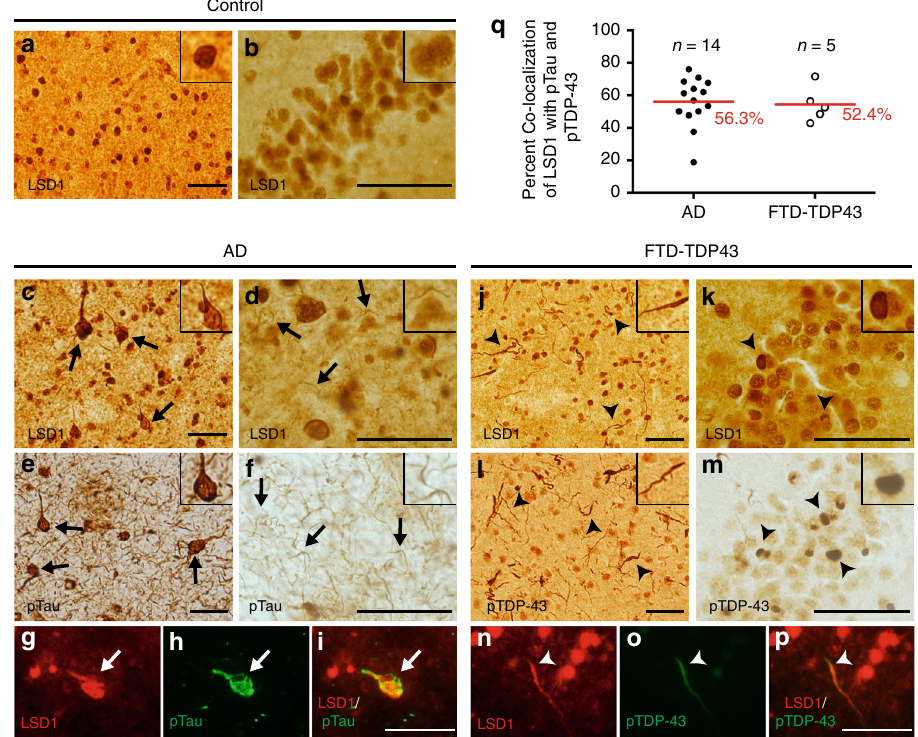
Fig. 6 LSD1 co-localization with pTau and pTDP-43 aggregates in AD and FTD. a , b LSD1 immunohistochemistry (IHC) showing expression of LSD1 in age-matched control frontal cortex a and hippocampus b . c , d Representative IHC images showing LSD1 immunoreactivity localized to cytoplasmic tangle- like aggregates ( c , arrows) and neurites ( d , arrows) in AD frontal cortex. e , f IHC images showing pTau (AT8 epitope) neuro fi brillary tangles ( e , arrows) and neuropil threads ( f , arrows) from the same AD frontal cortex as c , d . g – i Representative image of LSD1 ( g , red), pTau ( h , green), and merged i immuno fl uorescence (IF) showing co-localization of LSD1 with a pTau neuro fi brillary tangle in AD (arrow). j , k Representative IHC image showing LSD1 immunoreactivity localized to abnormal deposits in neurites ( j , arrowheads) and cytoplasmic inclusions ( k , arrowheads) in FTD-TDP43 frontal cortex j and hippocampus k . l , m IHC images showing pTDP-43 in neurites and cytoplasmic inclusions ( l , m , arrowheads) from the same FTD-TDP43 frontal cortex l and hippocampus m as j and k , respectively. n – p Representative image of LSD1 ( n , red), pTDP-43 ( o , green) and merged p IF showing co-localization of LSD1 with pTDP-43 in a neurite in FTD-TDP43 (arrowhead). Insets are magni fi ed views of LSD1 nuclear localization a , b and representative pathologies c – f , j – m . Scale bar = 50 µ m. q The percentage of neuro fi brillary tangles (pTau) with LSD1 co-localization in AD ( n = 14 cases assayed, closed circles), and neurites (pTDP-43) with LSD1 co-localization in FTD-TDP43 ( n = 5 cases assayed, open circles), with the average percentage shown (red